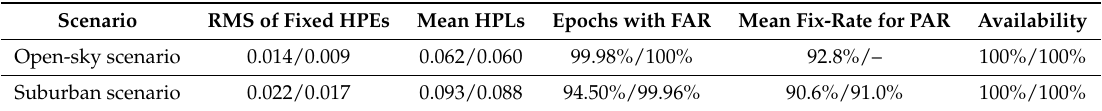
Figure 8. Ambiguity-fixed horizontal positioning errors (HPEs) and horizontal protection levels (HPLs) during T1 for: ( a ) the open-sky scenario and ( b ) the suburban scenario. Table 5. Statistics of the ambiguity-fixed HPEs and the HPLs for the time periods T1 and T2. The values for T1 and T2 are separated by